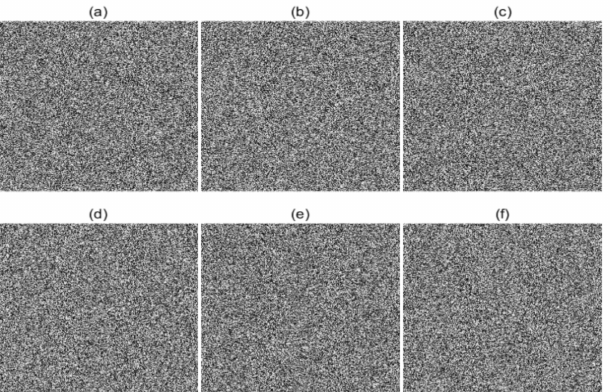
Figure 12. Key sensitivity analysis. Encrypted image with: ( a ) a1 = 4 − 10 − 14 ; ( c ) a2 = 3.77 − 10 − 14 ; ( e ) p1 = 0.499 − 10 − 14 ; ( g ) p2 = 0.37 − 10 − 14 ; ( i ) x1 = 0.1260 − 10 − 14 ; ( k ) x2 = 0.3265 − 10 − 14 . ( b ) Difference between ( a ) and Figure 10e; ( d ) difference between ( c ) and Figure 10e; ( f ) difference between ( e ) and Figure 10e; ( h ) difference between ( g ) and Figure 10e; ( j ) difference between ( i ) and Figure 10e; ( l ) difference between ( k ) and Figure 10e.